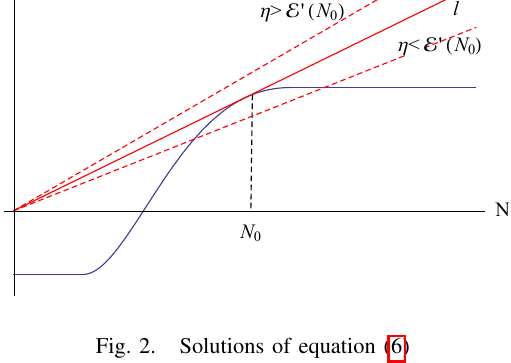
Fig. 2. Solutions of equation